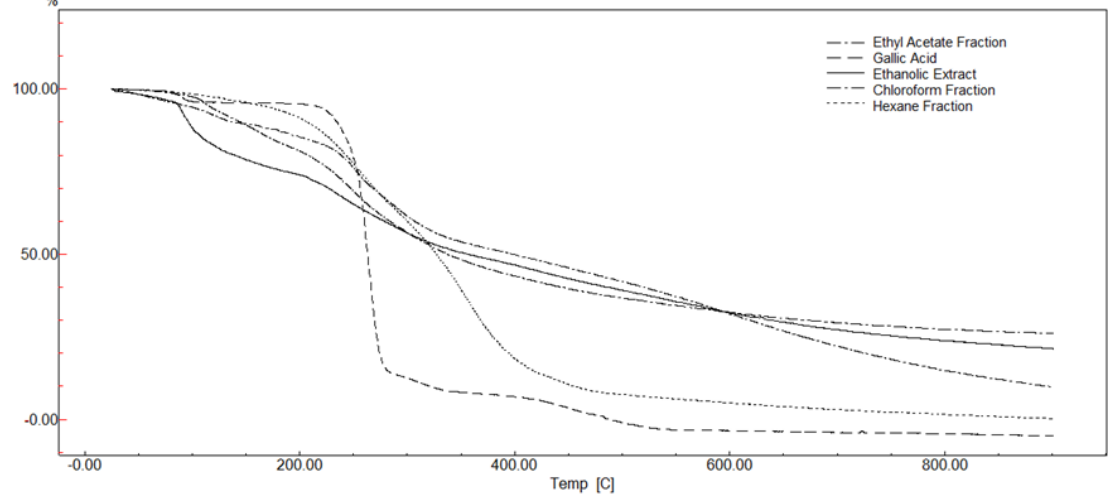
Figure 2. TG curve of gallic acid and the samples produced from the extract of S . brasiliensis Engl.